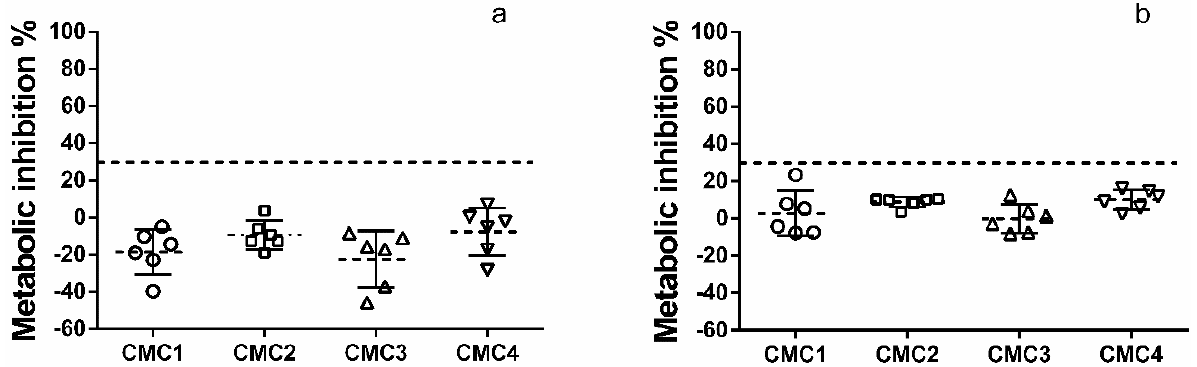
Figure 3. Cytotoxicity of CMCs towards HaCaT ( a ) and HDFa ( b ) cells. The dotted line represents the 30% cytotoxicity limit as defined by the ISO 10993-5:2009 standard. For both cell lines, the studied CMCs cytotoxicity values were below the 30% thresh- old (dotted line) defined by the ISO 10993-5:2009 standard [30]. However, while no